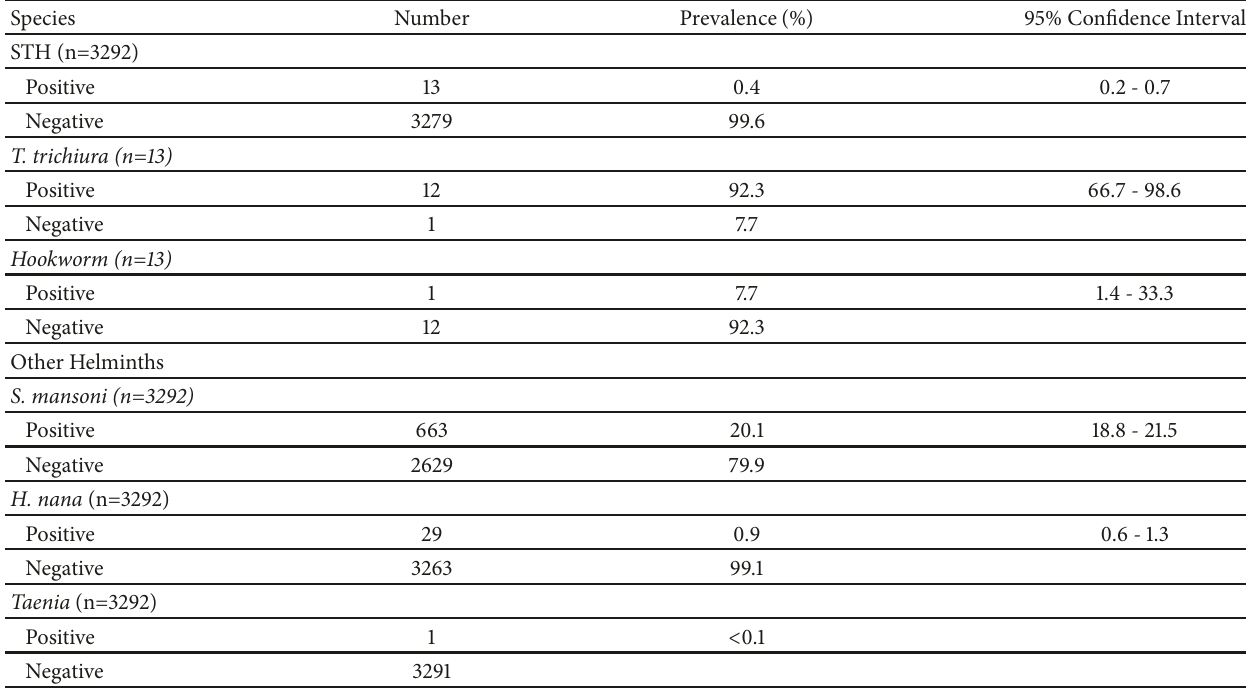
Table 2: Prevalence of STH and other helminths among the study participants.